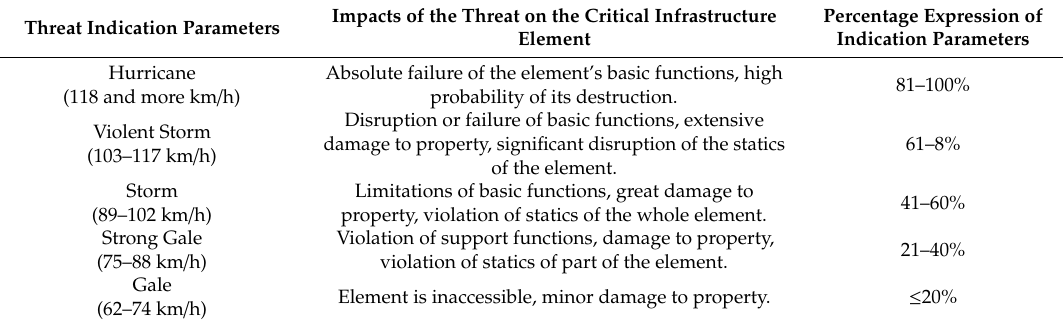
Table 4. Example of classification of indication parameters for the threat of “extreme